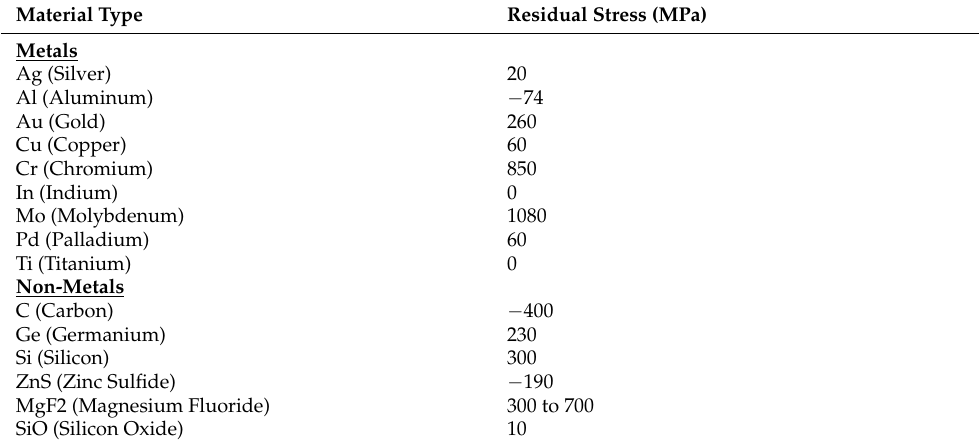
Table 13. Residual for a Number of Different Materials Deposited Using Evaporation Physical Vapor Deposition